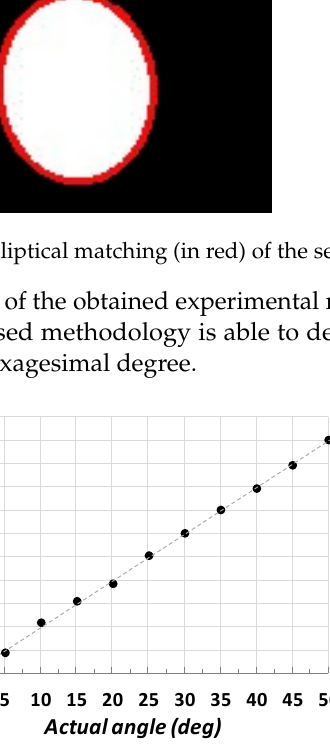
Figure 7. Geometrical model for rotation shifts.